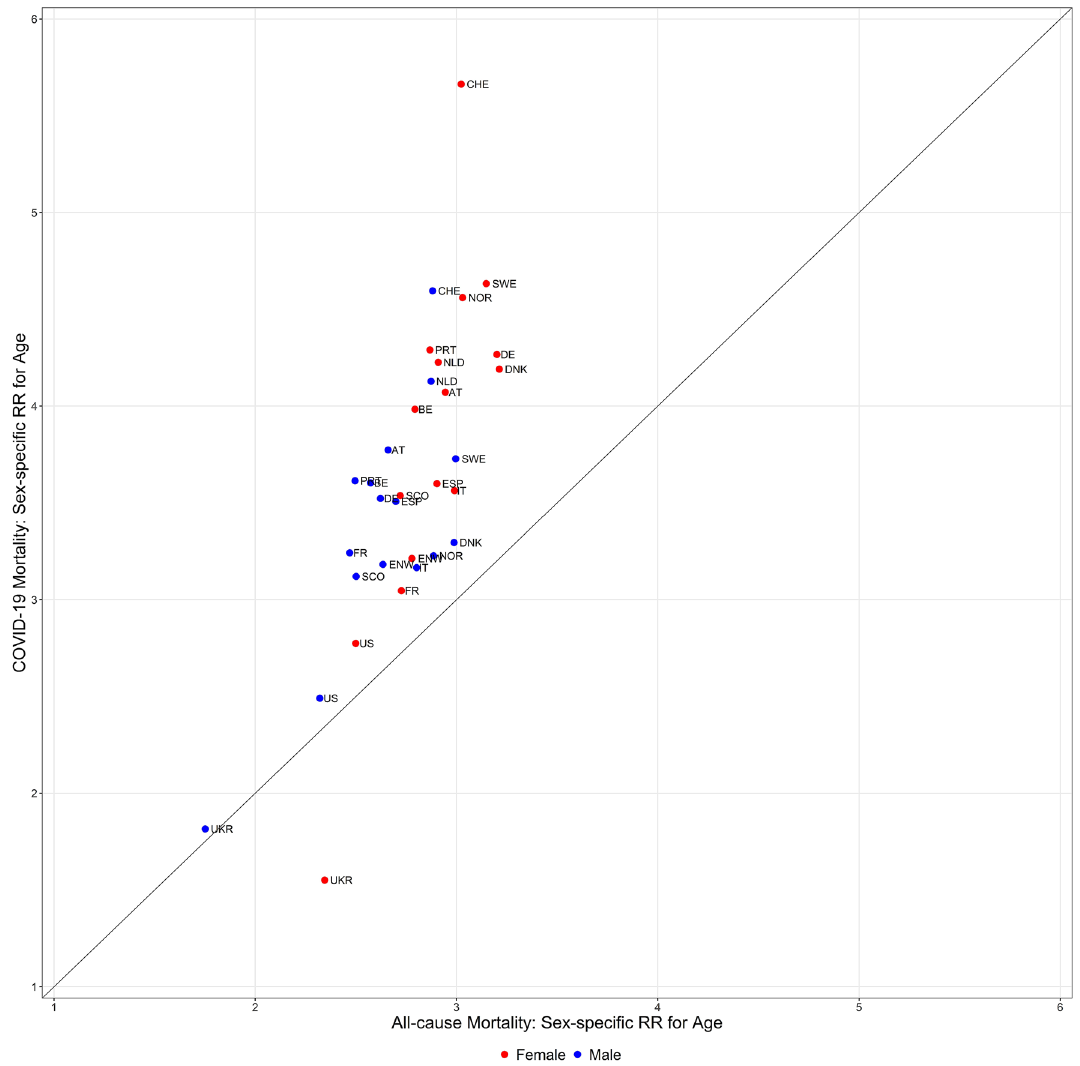
Figure 3. Association of the risk ratios for age between all-cause and COVID-19 deaths. The scatterplot shows the risk ratios for the age of males (blue dots) and females (red dots) estimated for COVID-19 mortality in 2020 versus the corresponding risk ratios estimated for all-cause mortality before 2020. The risk ratios are estimated from Model 1 COVID and Model 1 ALL . Country codes are defined in Table